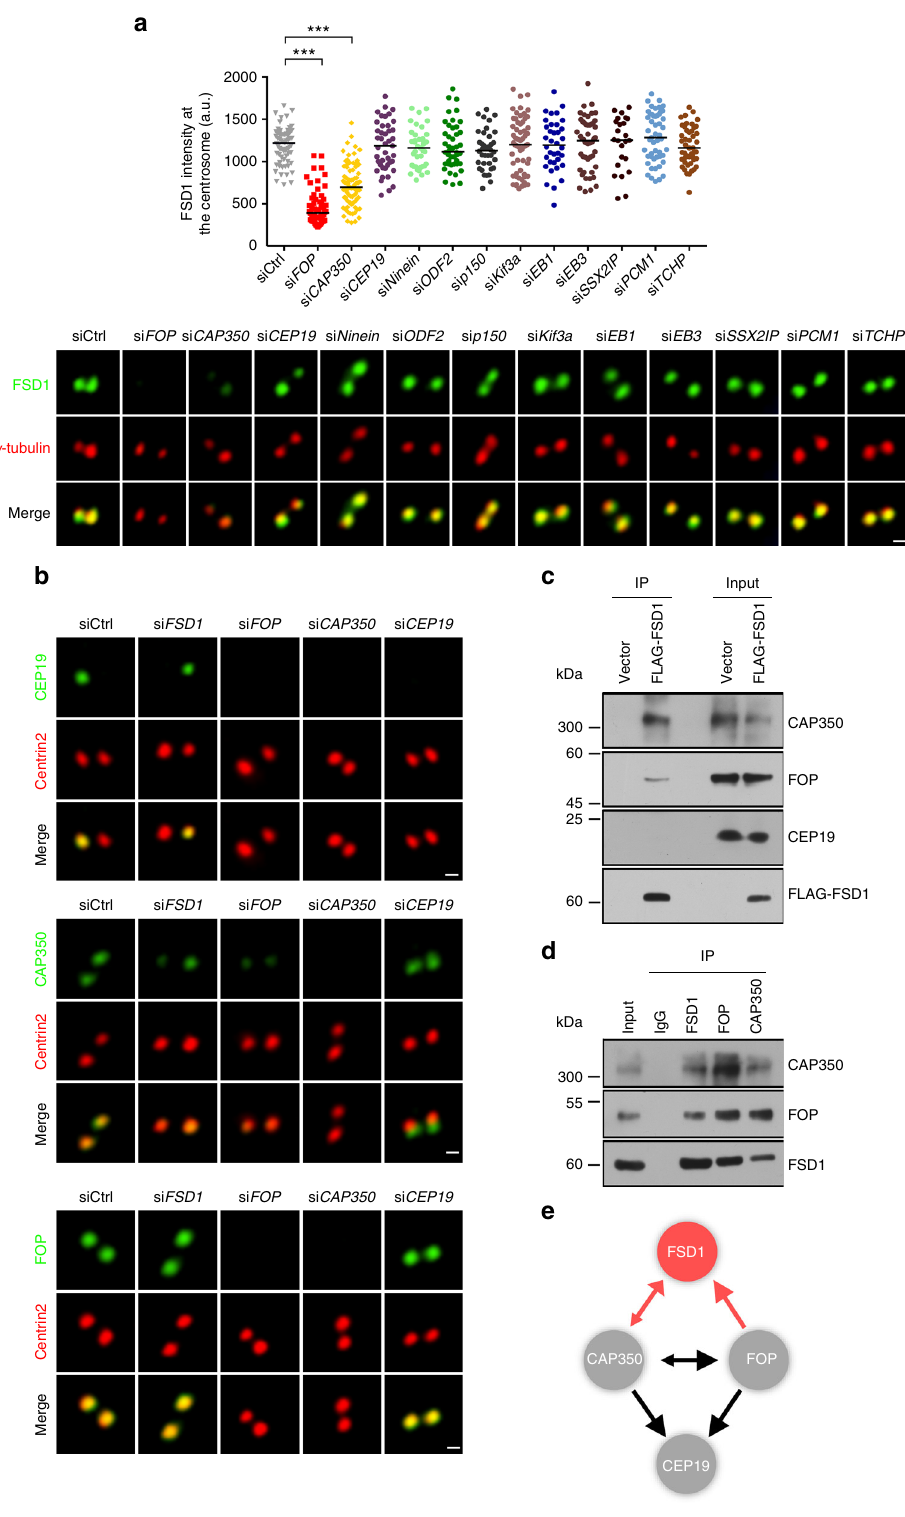
880 (Figs. 4, 6, and 8) or a ×100/1.40 oil objective on Zeiss LSM 880 with airyscan (Figs. 5 and 6) or a ×63/1.40 oil objective on Nikon Eclipse Ti-E Microscope with an Ultra View spinning-disc confocal scanner unit (Perkin Elmer) (Fig. 5). All acquisition settings were kept constant for experimental and control groups in the same experiment. The representative images acquired by DV system were processed by iterative constrained deconvolution (SoftWoRx, Applied Precision Instruments). All quanti fi cation was performed on raw images without deconvolution. Brie fl y, the raw images were analyzed with Volocity 6.0 software. To quantify the